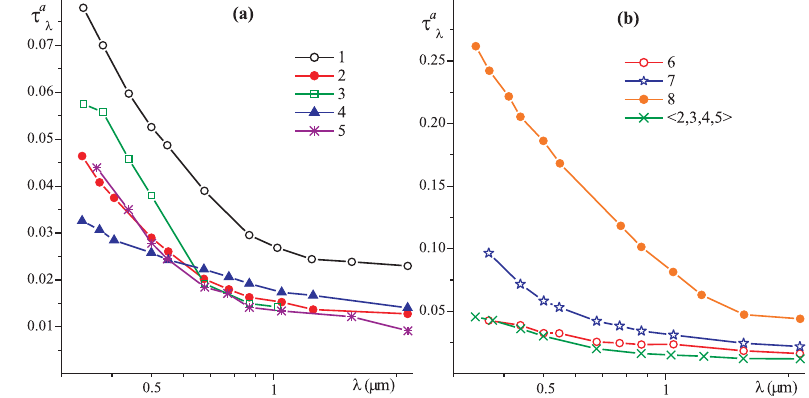
Figure 2. Average spectral dependences of AOD in the regions of (a) the Arctic and (b) Far East seas (symbols < 2, 3, 4, 5 > indicate the average AOD values for the Arctic regions